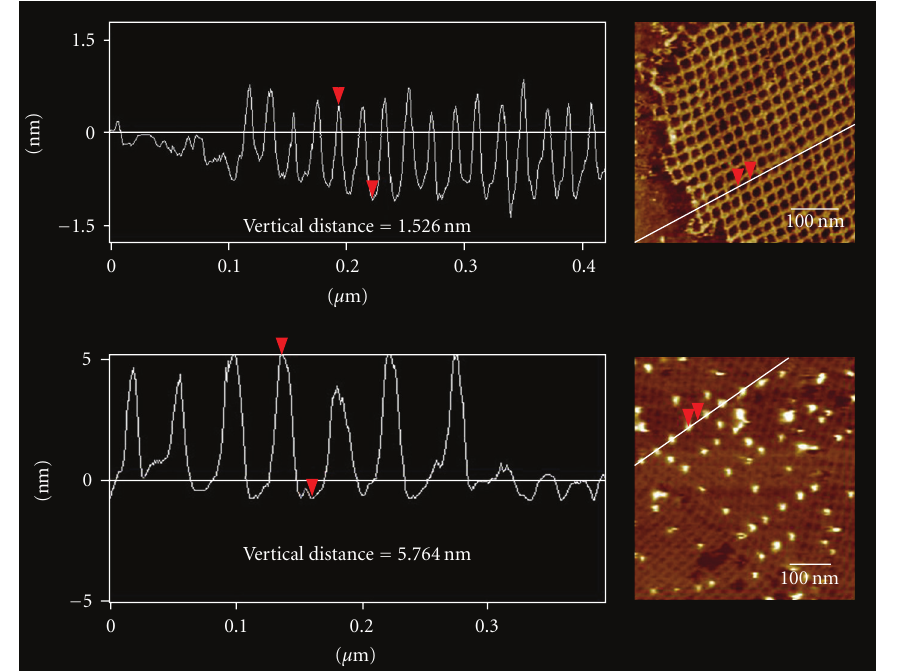
Figure 4: AFM profile scans of a DNA lattice (top) and a DNA lattice incorporating POC isolated from reaction 3 after addition of 5 nm gold nanoparticles